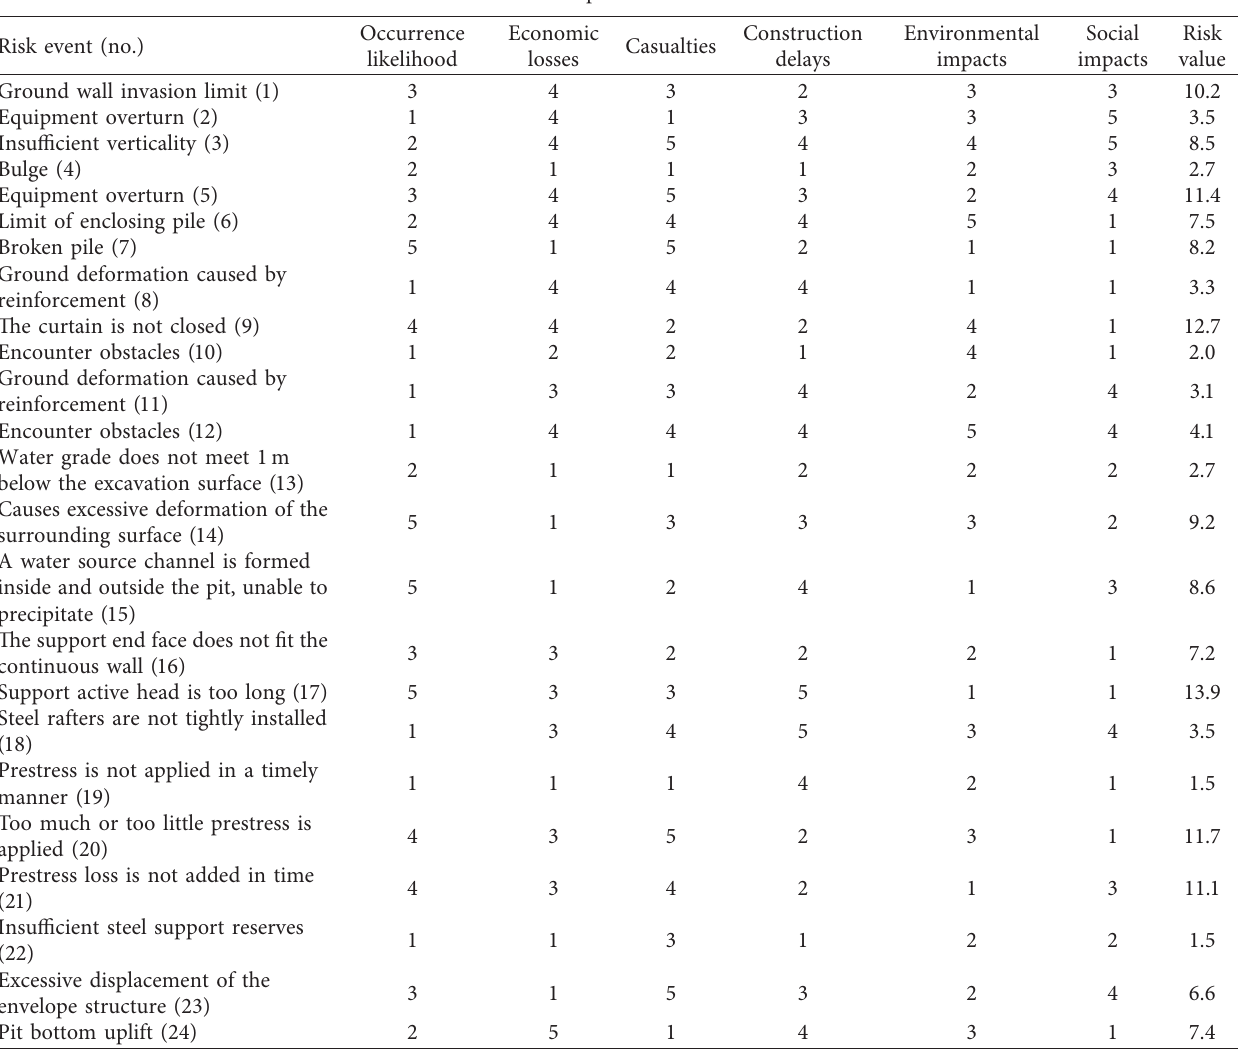
Figure 5: Radar chart of the risk event evaluation index. Table 7: Expert 1 score